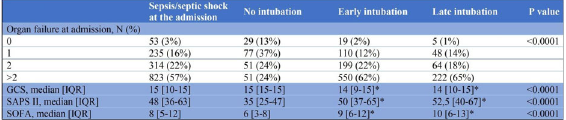
Table 1 (abstract 000946). See text for